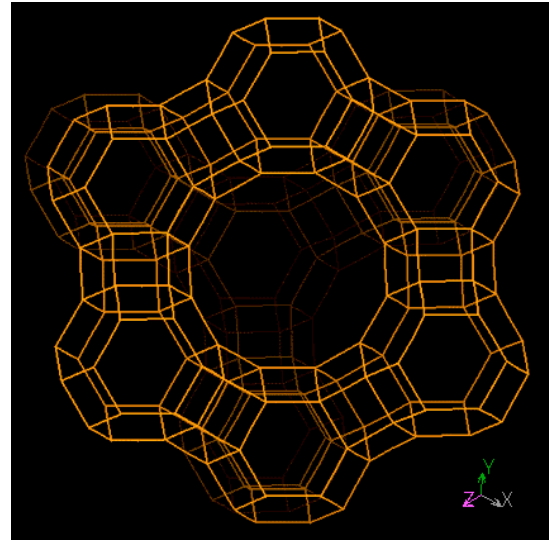
Figure 2. The FAU type zeolite supercage (viewed along